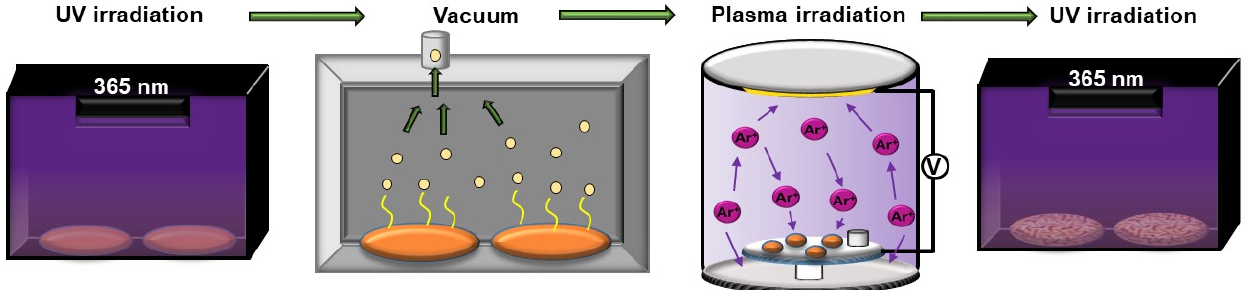
Figure 1. Schematic representation of the subsequent steps used to generate the wrinkle patterns.